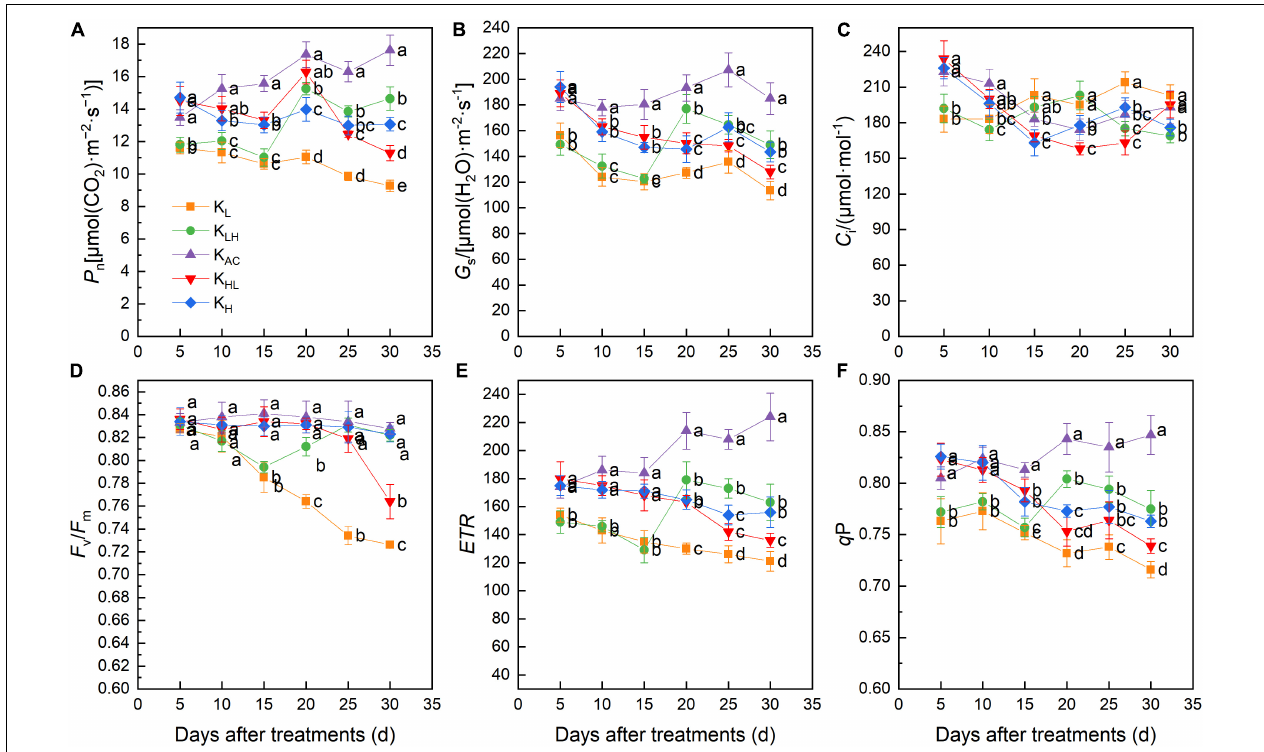
FIGURE 4 | Effects of different K treatments on the P n (A) , G s (B) , C i (C) , F v / F m (D) , ETR (E) , q P (F) of M9T337 rootstocks. Data show the means ± standard deviation of three independent samples. Different letters on vertical bars indicate significant differences ( P < 0.05). P n , net photosynthetic rate; G s , stomatal conductance; C i , intercellular CO 2 concentration; F v / F m , maximum photochemical efficiency; ETR, electron transfer rate; q P, photochemical quenching